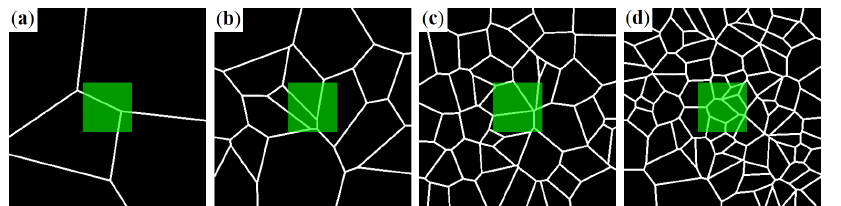
Figure 10. Realizations of 2D networks in images of 400 × 400 pixels. The expected number of generators or cells in this area λ is varied: ( a ) 10; ( b ) 20; ( c ) 40; and ( d ) 80. The green overlay indicates the 100 × 100 pixel sub-region finally used.